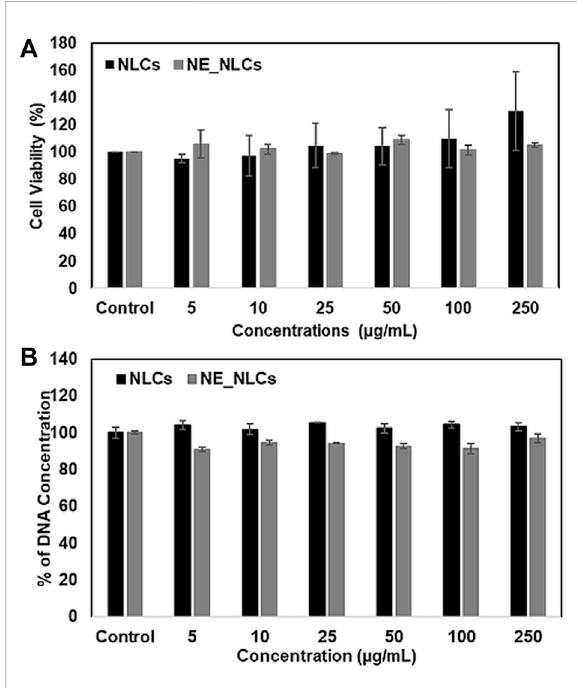
FIGURE 3 Cytocompatibility evaluation of NLCs and NE_NLCs at increasing concentrations: WST-1 metabolic assay, indicative of cell viability (A) , and PicoGreen dsDNA quanti fi cation, indicative of cellular proliferation (B). Data are represented as mean values ±standard deviation ( n =